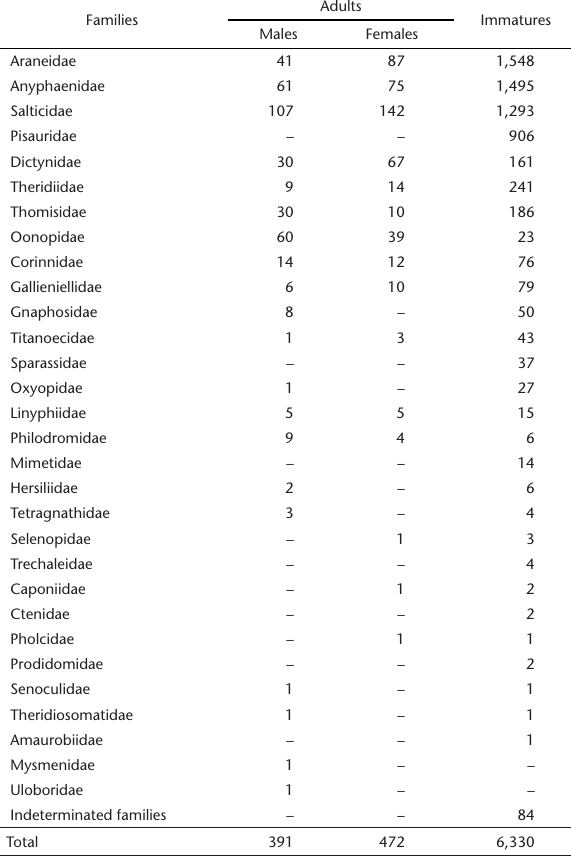
Table 1. Total abundance (number of individuals) of males, females and immatures of spiders sampled throughout the different seasonal periods in canopies of Vochysia divergens in the northern region of the Pantanal of Mato Grosso,